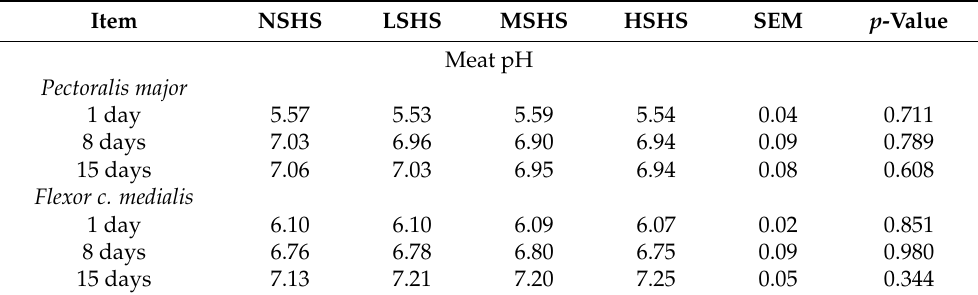
Table 4. Effects of level of electrical stunning, halal way neck cutting, and subsequent bleeding on the Pectoralis major and Flexor cruris medialis pH in broiler chickens.